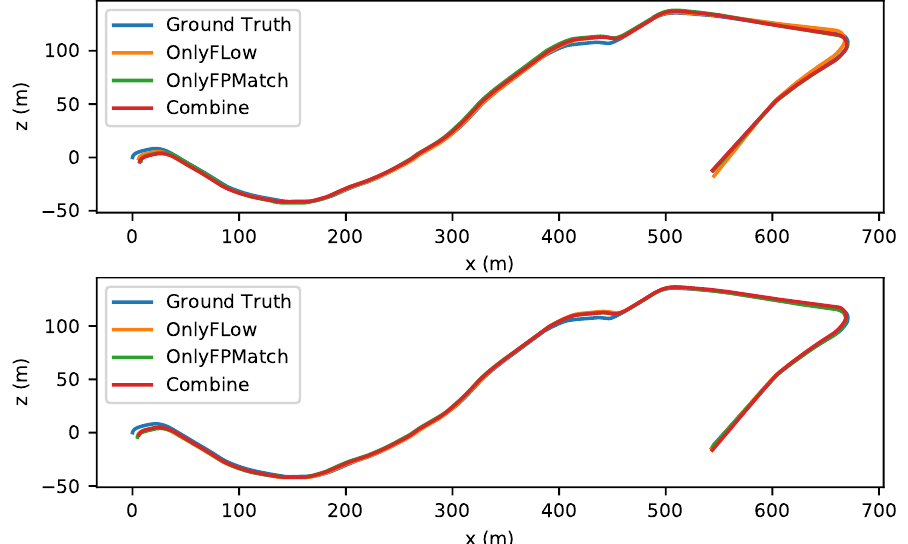
Figure 8. The upper image shows the estimated trajectories of a normal-motion scene (stride = 1). The lower image shows the results from a small-amplitude-motion scene (stride = 2) in sequence 10 of the KITTI